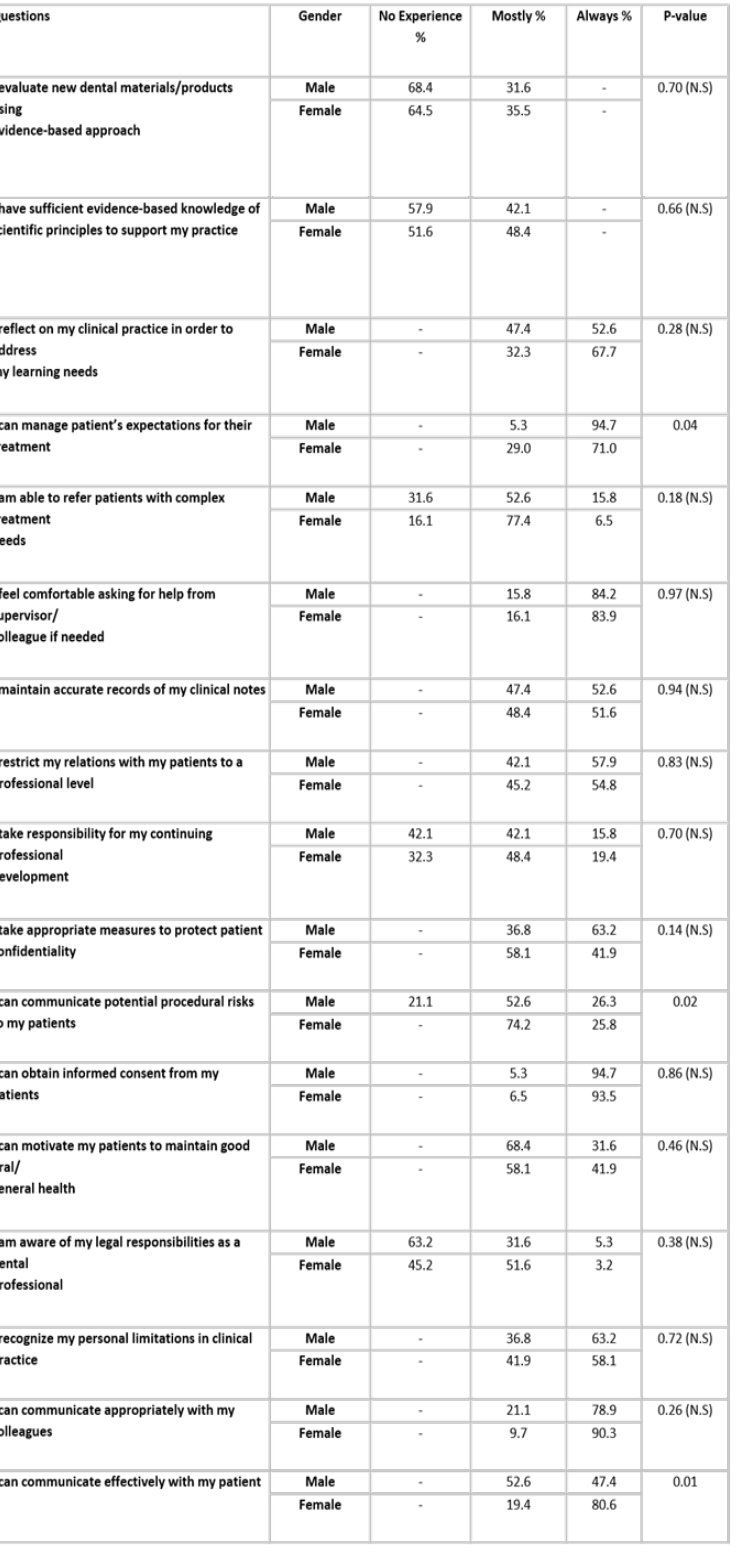
Table 7: Self-perceived preparedness related to cognition, communication and professional skills of the final year dental